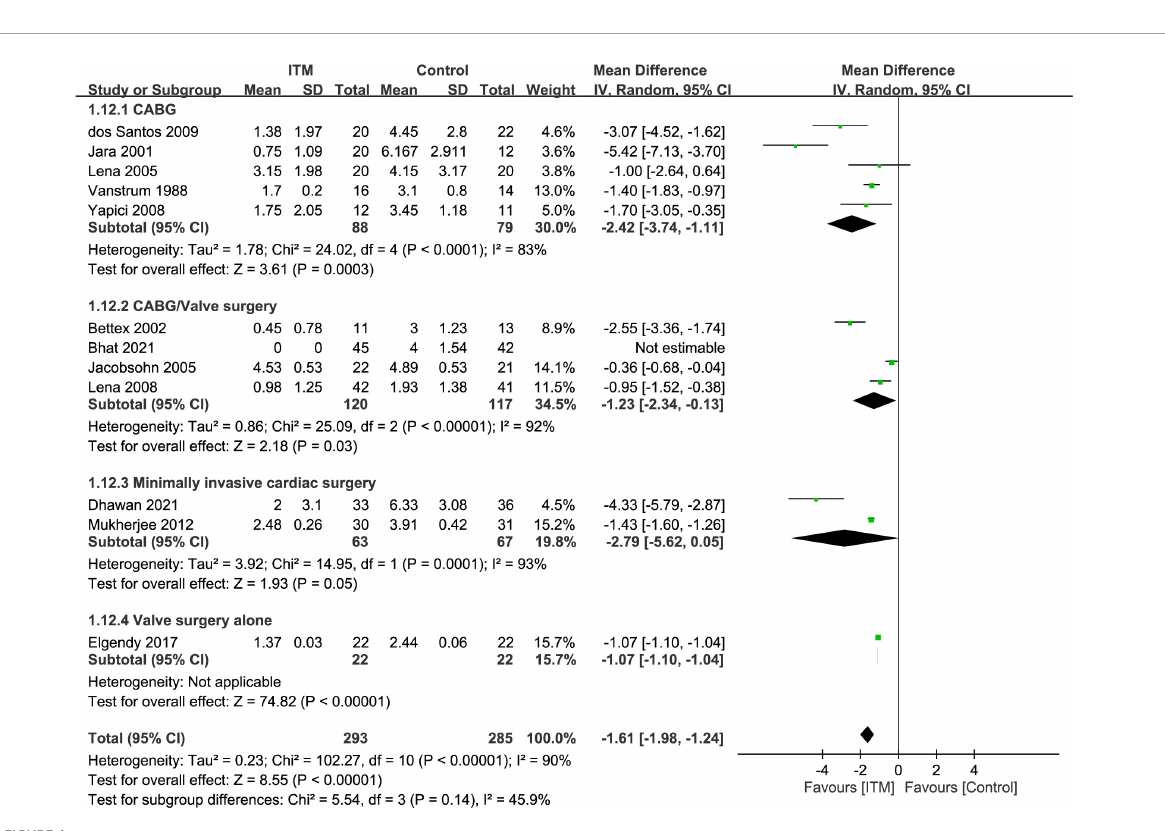
FIGURE4 Subgroup analysis comparing postoperative 24-h pain score between intrathecal morphine (ITM) and control groups based on type of cardiac surgery. CI, confidence interval; IV, inverse variance; SD, standard